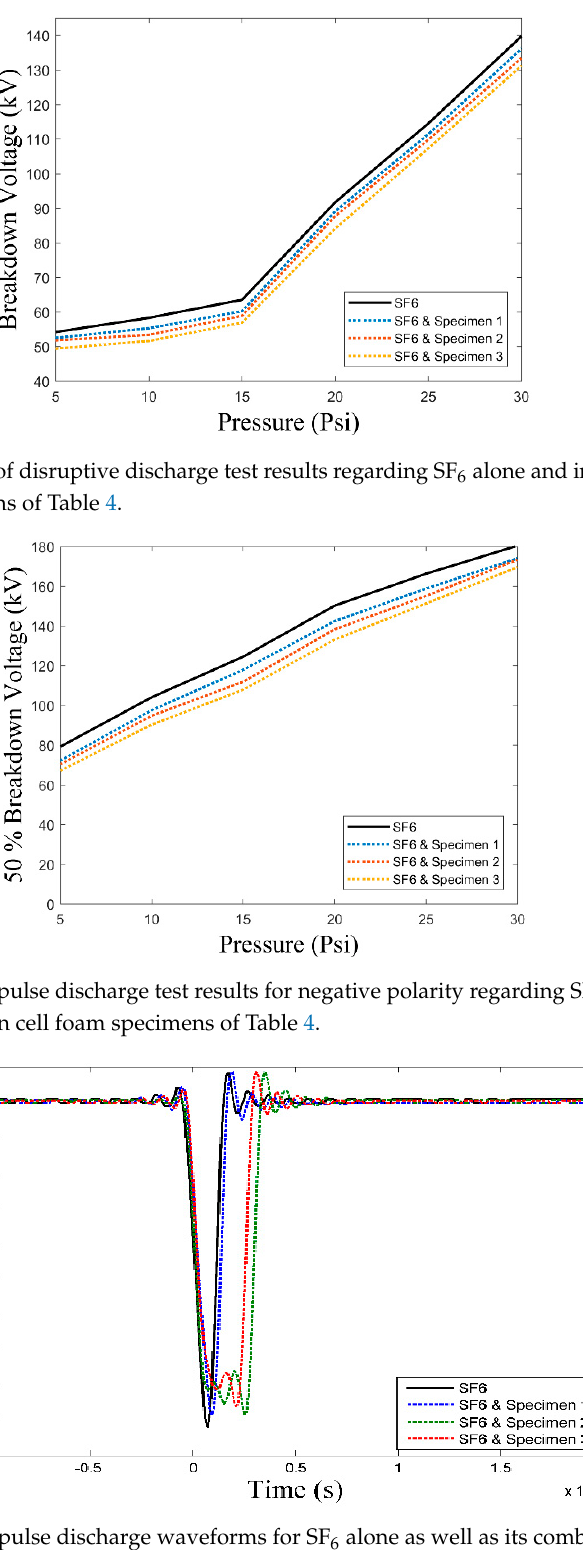
Figure 18. Lightning impulse discharge waveforms for SF 6 alone as well as its combination with open cell foam specimens of Table 4 at 30 psi.